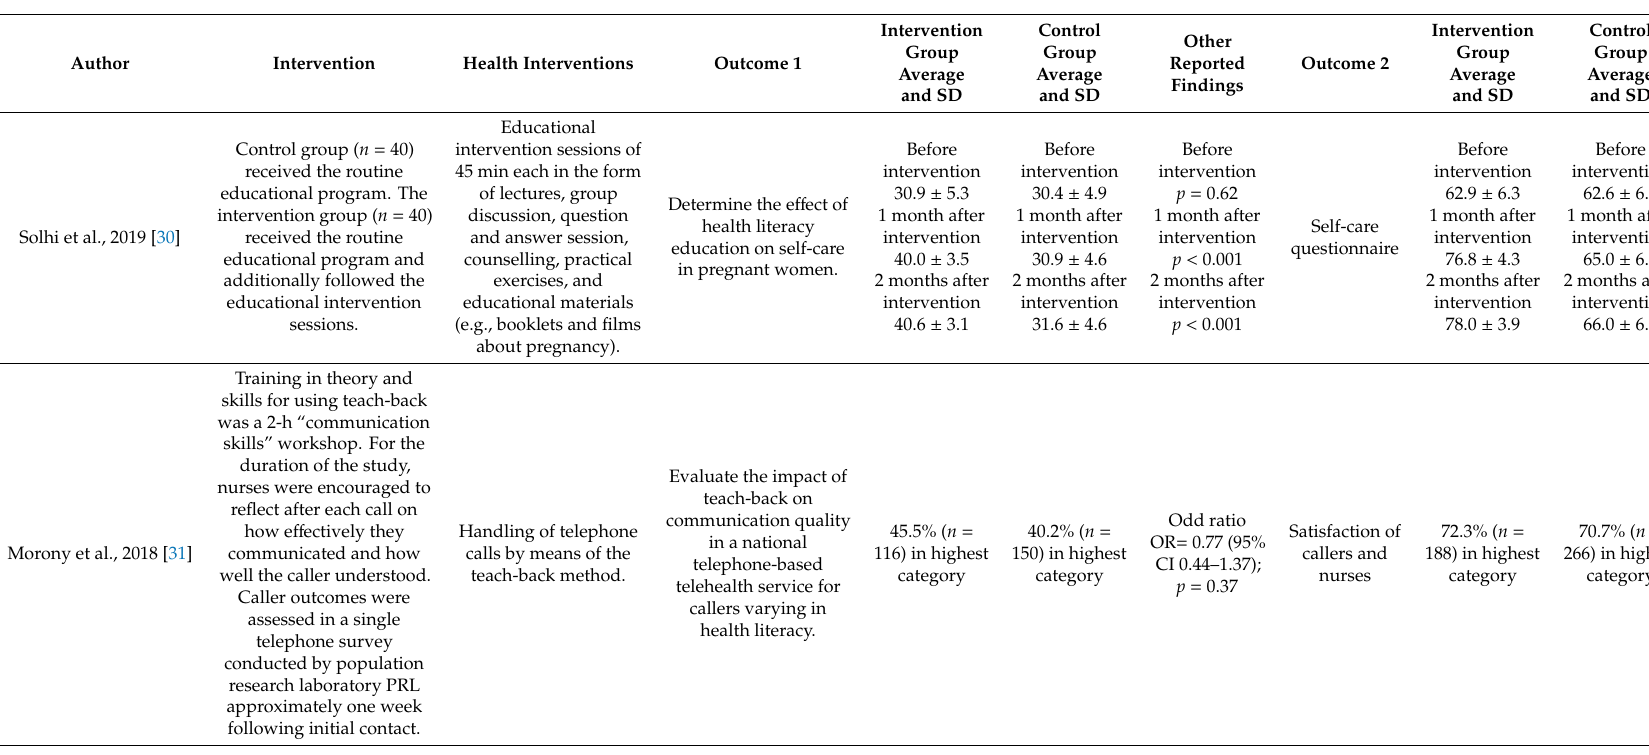
Table 3. Description of articles that explored health